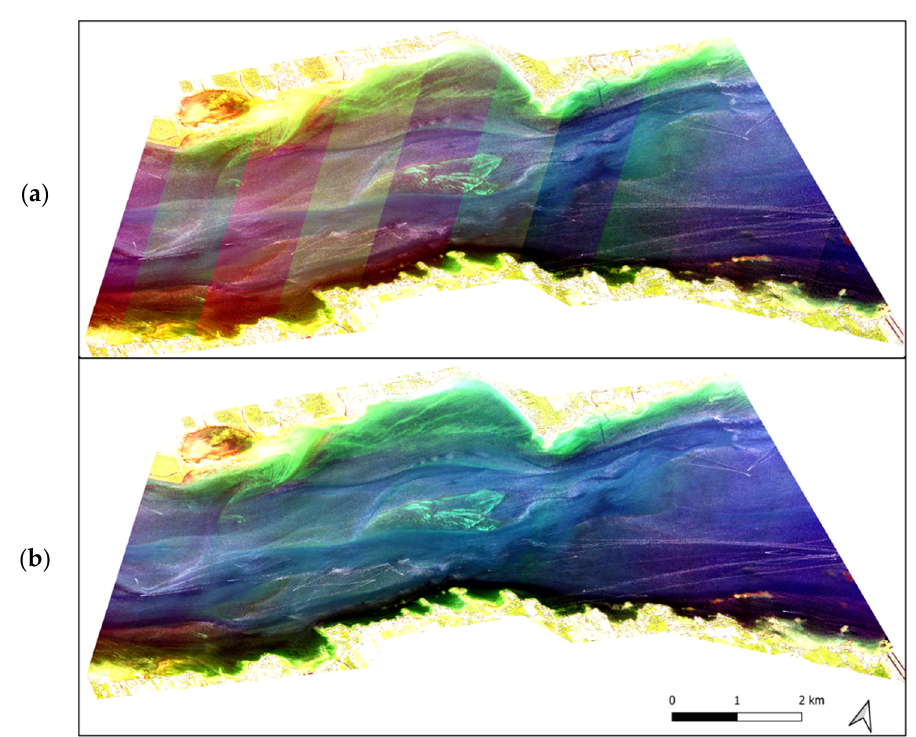
Figure 5 . RGB composite of the 2019 Worldview-03 image of lake Saint-François (© 2022 Maxar Technologies) before ( a ) and after ( b ) empirical de-striping.